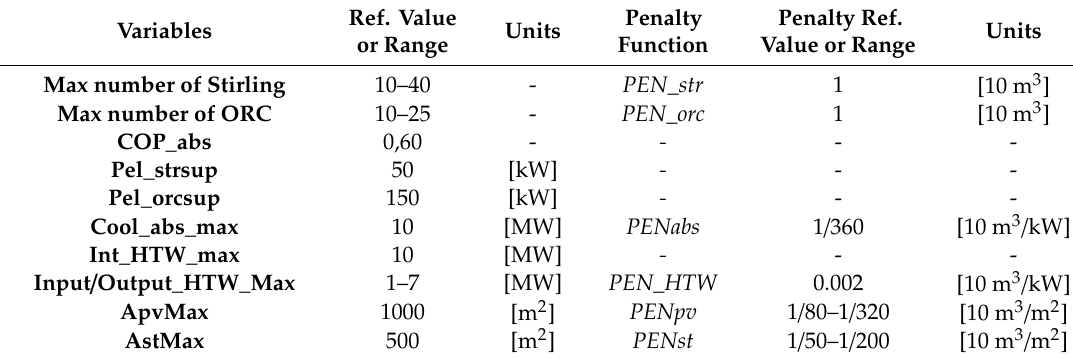
Table 3. Main design variables, with their variation ranges and penalty coe ffi